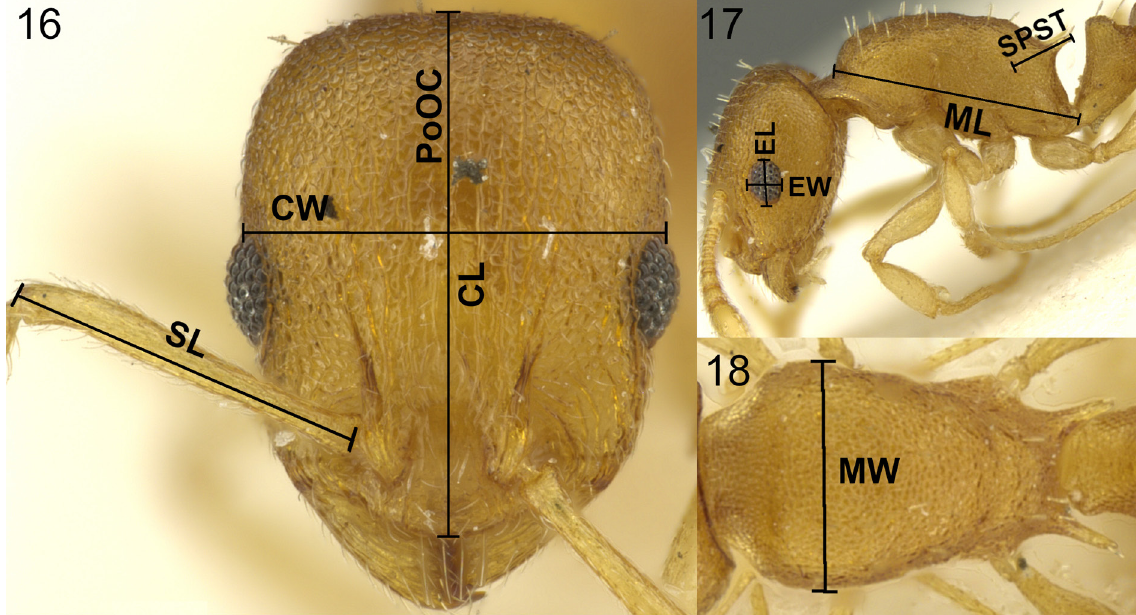
Figs 16–18. Morphometric characters recorded from workers of Temnothorax Mayr, 1861 in this study. The background image is a paratype worker of T. lagrecai (Baroni Urbani, 1964) from the Natural History Museum of Vienna, photos by Anna Pal available from www.antweb.org, specimen identifier CASENT0919741. 16 . Head view. 17 . Lateral profile view. 18 . Dorsal view of the